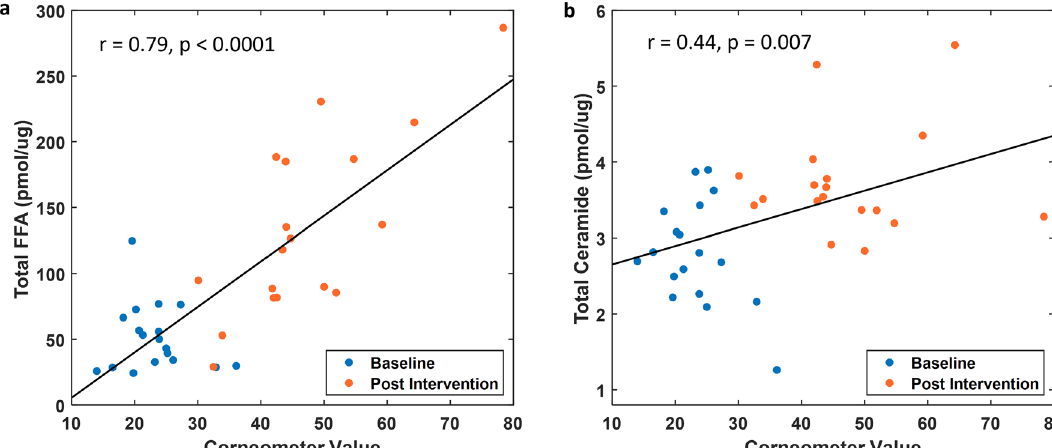
Figure 2. Skin hydration correlates with fatty acid and ceramide levels. Scatter plots of corneometer readings of skin hydration vs. the total level of FFA ( a ) and total ceramides ( b ). Blue and red circles represent untreated and after 5 weeks of product application. The solid line represents the optimal fit from simple linear regression analysis, with the correlation coefficient r and p-value displayed. Statistical significance was considered as p-value < 0.05.